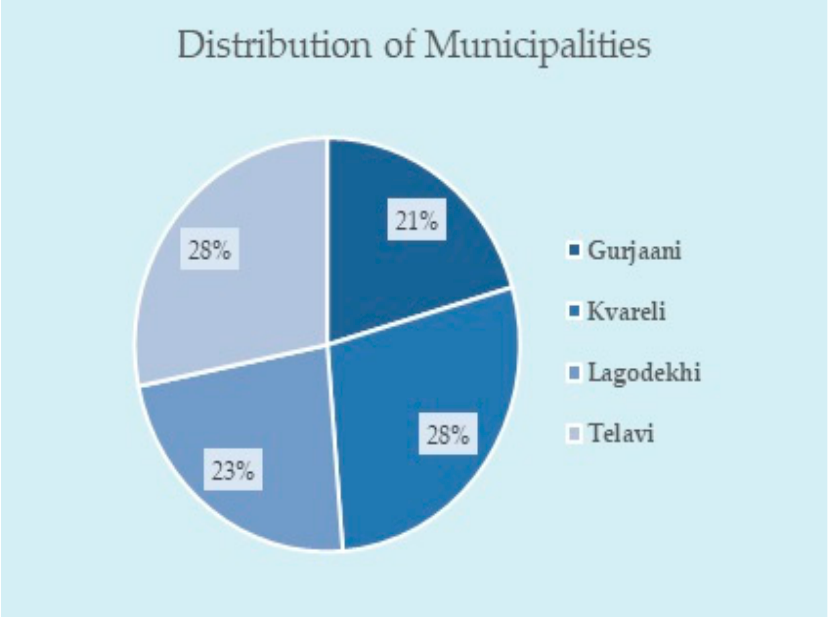
Figure 10. Distribution of municipalities of respondents .